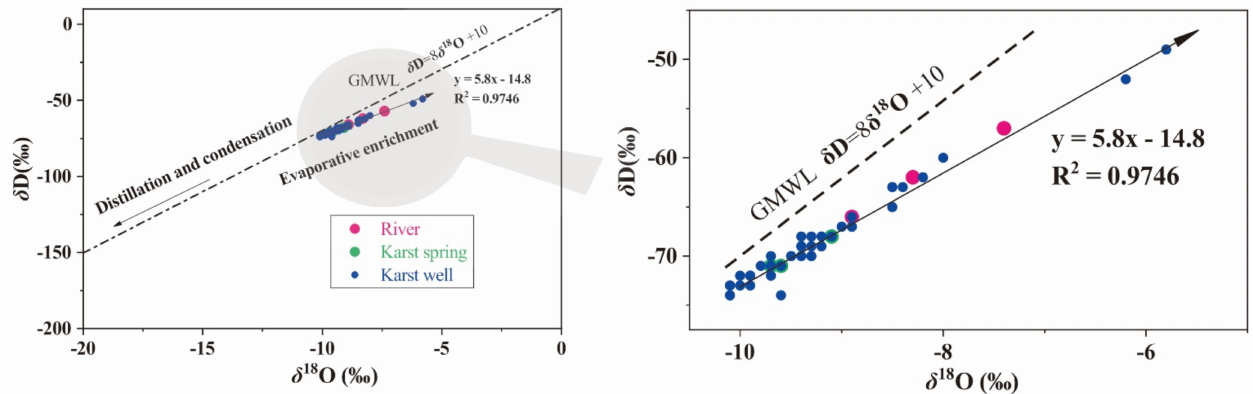
Figure 14. Relationships between δ D vs. δ 18 O for the karst